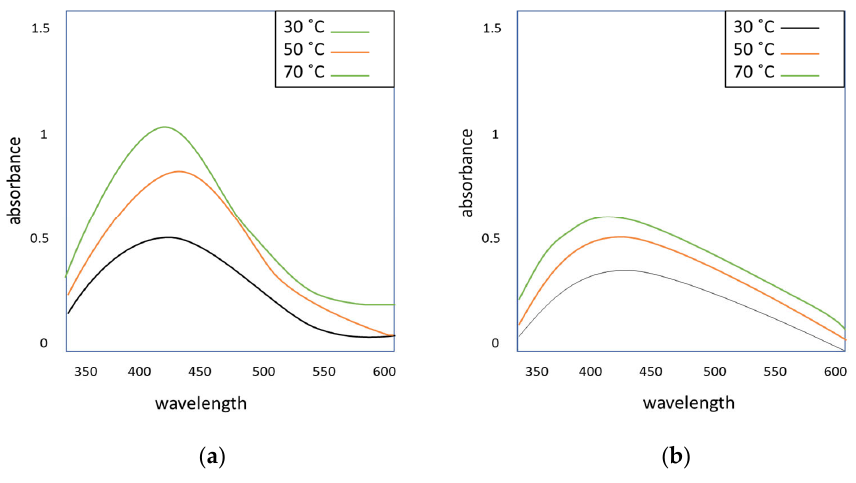
Figure 3. Effect of temperature on the preparation of SNPs ( a ) for TSADE and ( b ) for TSFPE. After monitoring the effects of various factors, i.e., plant extract concentration, pH, are a pH 7, at 70 °C, with 5 mg/1 mL